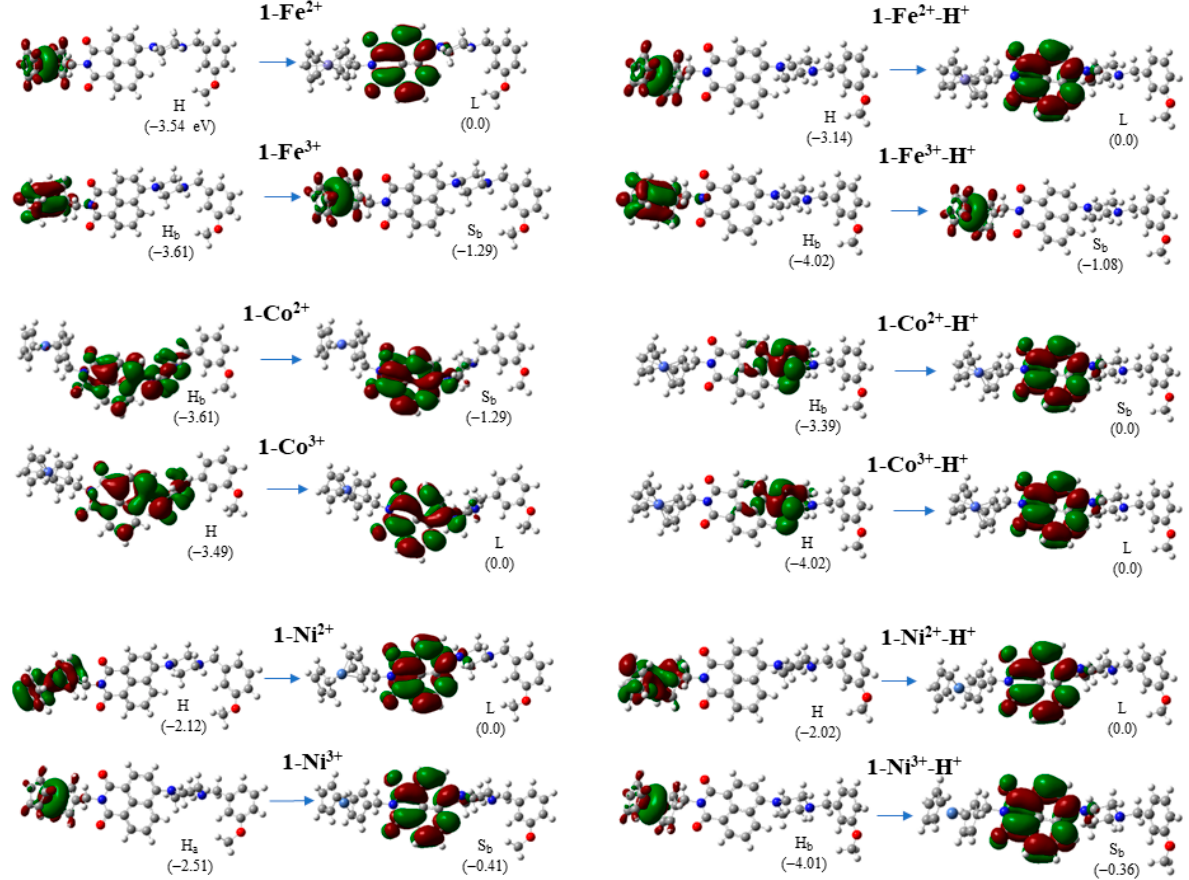
Figure 6. H, L, or S molecular orbitals of the calculated minima structures involved in the first absorption peak in the visible area at PBE0/6-31G(d,p) in THF solvent. Relative energies of orbitals in eV are included with respect to the L orbital. C atoms: grey balls, H atoms: white, O atoms: red; N atoms: blue, M (Fe, Co,Ni) atoms: